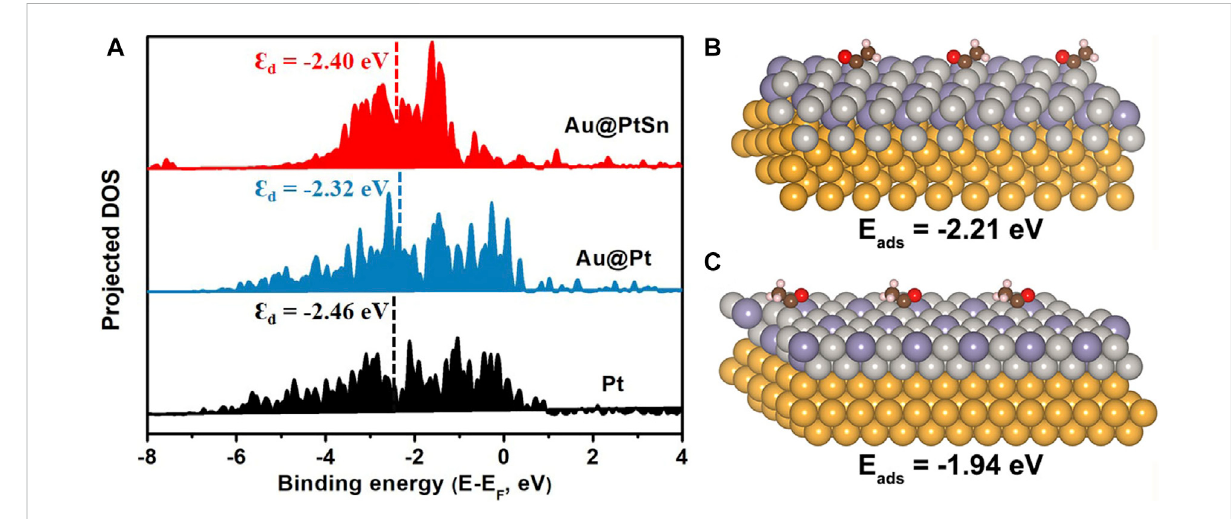
FIGURE 5 (A) PDOS of the Pt 5 days orbits on the surfaces of the Au@PtSn, Au@Pt and Pt models (B,C) Adsorption energies of *CH the Au@PtSn and Au@Pt 3 Sn models,